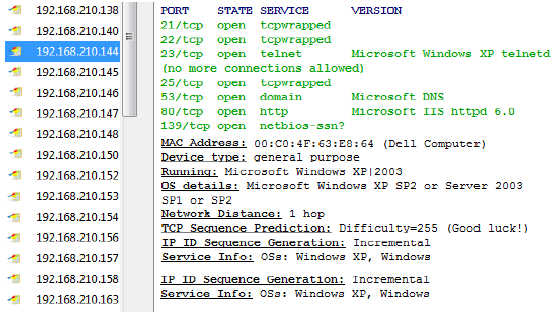
Fig.9. Detected services and version of low interaction honeypot through high interaction honeypot